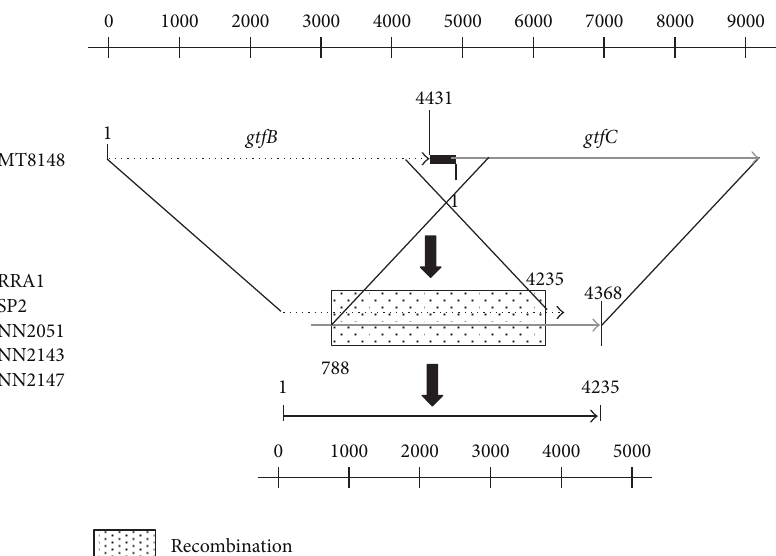
Figure 3: Illustration of gtfB - gtfC gene location in MT8148 and fusion strains. The recombination was found located at a position 4235 bp downstream of gtfB and 788bp upstream of gtfC . The gtfB and gtfC genes used are listed in DDBJ as accession No. D88651 and